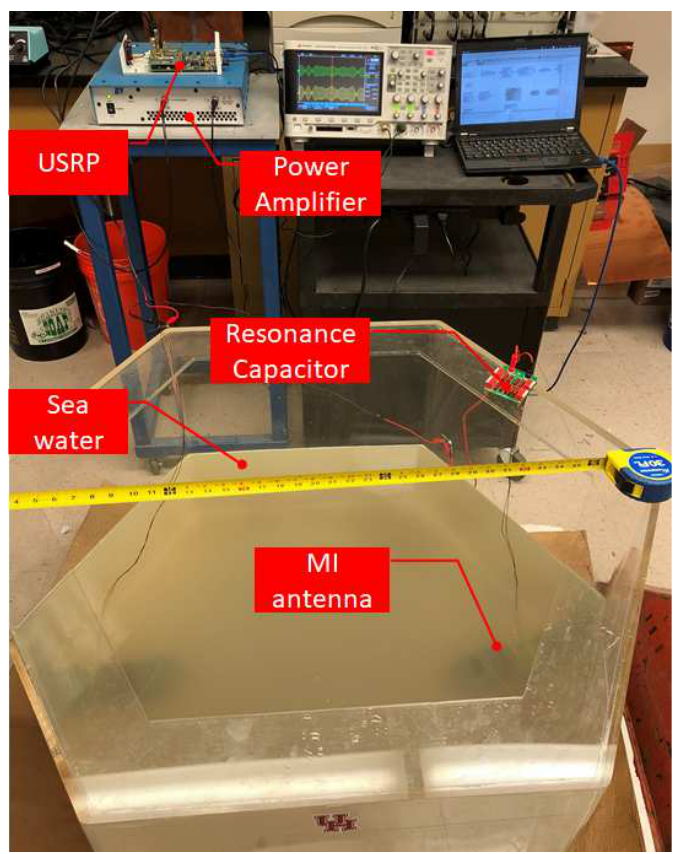
Figure 3. Sub-sea MI communication testbed.